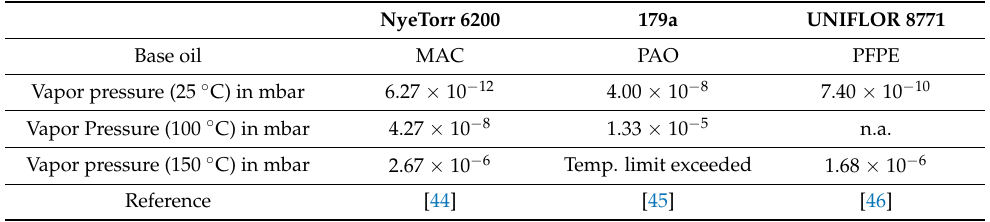
Table 7. Vapor pressure of different vacuum suitable lubricants at different